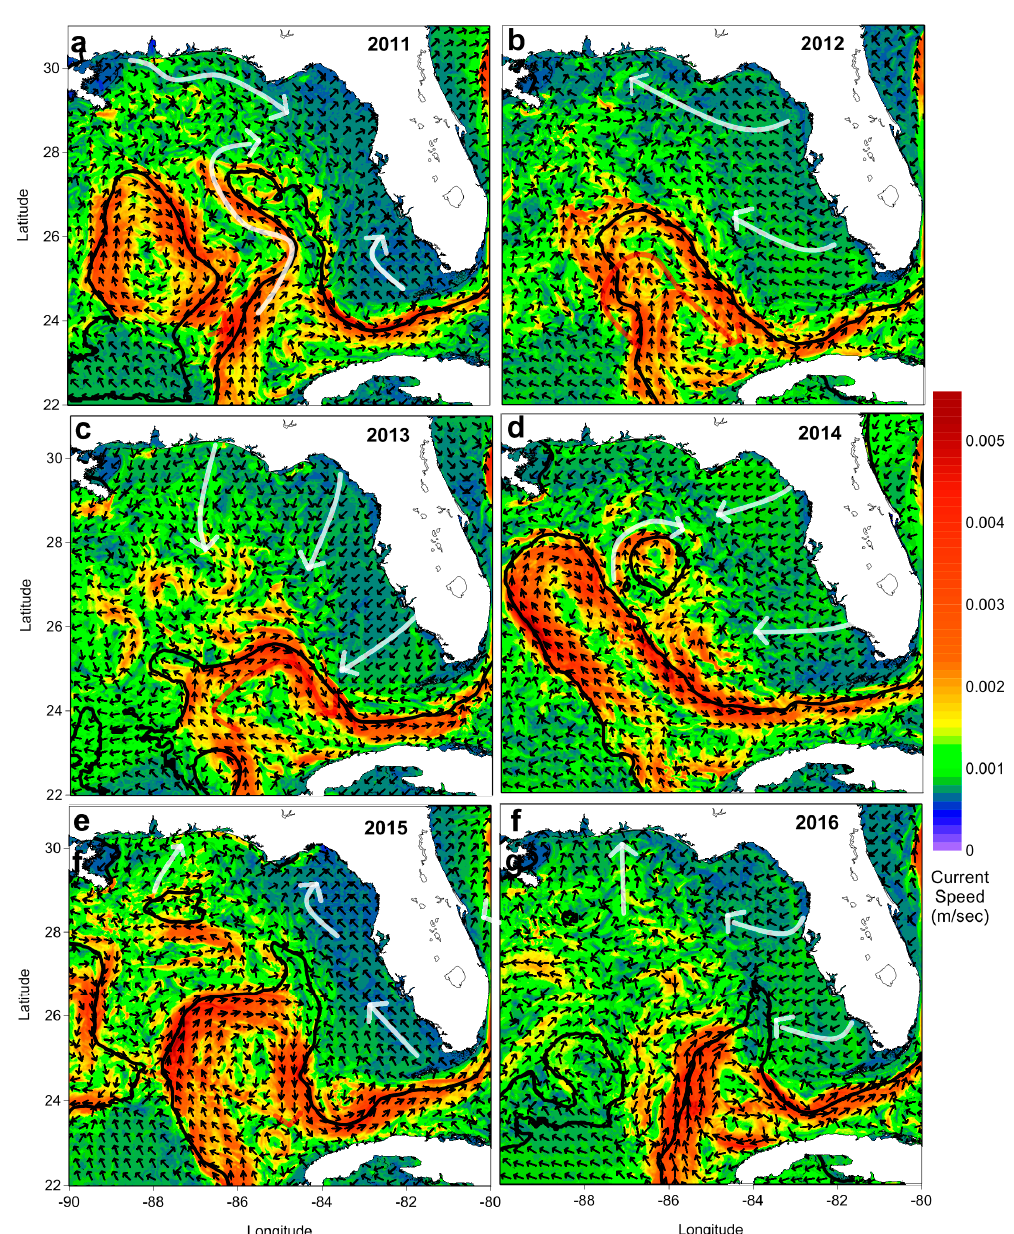
Figure 4. Surface current vectors (black arrows) and the respective current speed in color (m/s), averaged for ( a ) 2011, ( b ) 2012, ( c ) 2013, ( d ) 2014, ( e ) 2015, and ( f ) 2016. The black lines indicate the anticyclonic features derived from the simulated mean annual Sea Surface Height (SSH) fields. The white arrows highlight the prevailing circulation that affects the MAFLA and WFS shelves.